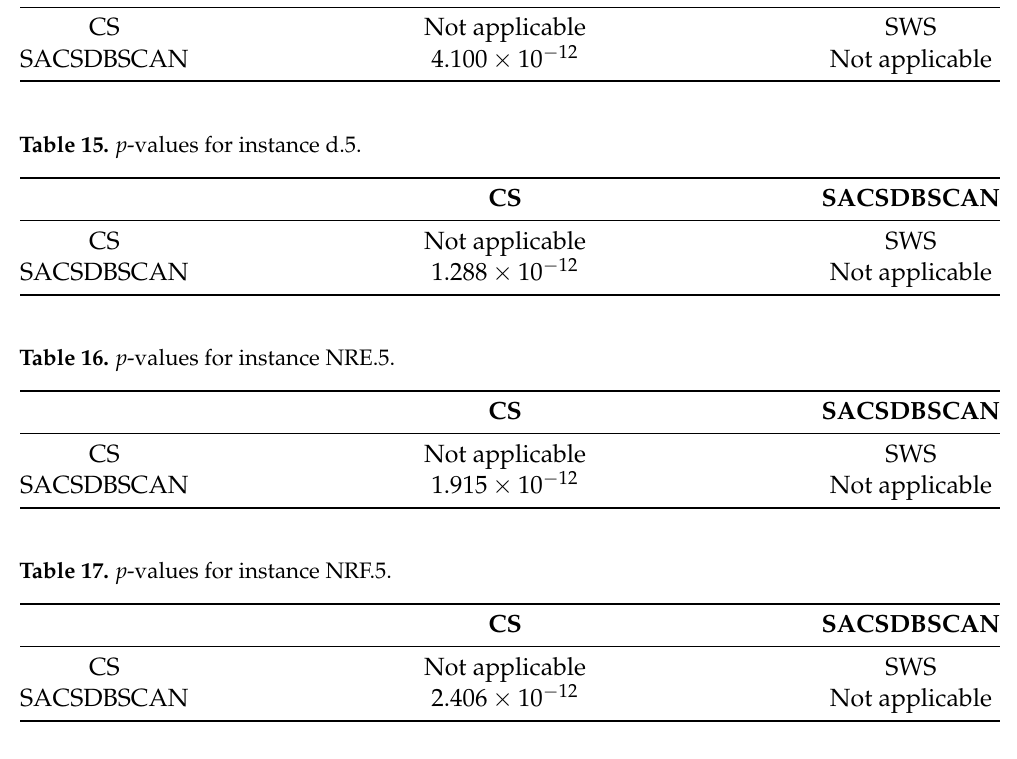
Table 18. p -values for instance NRG.5.